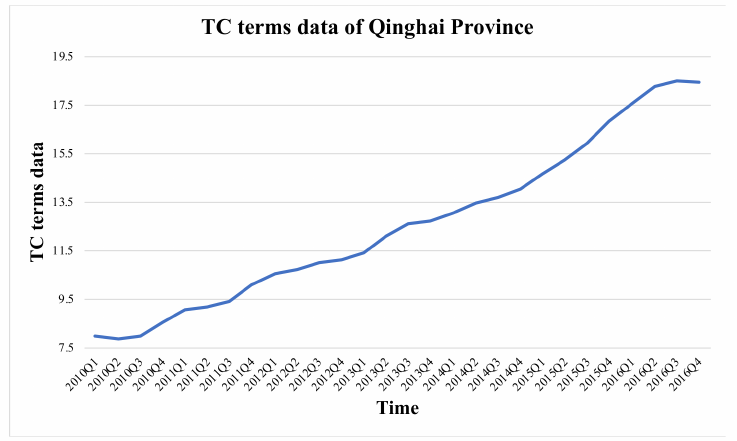
Figure 6. TC terms data of Qinghai